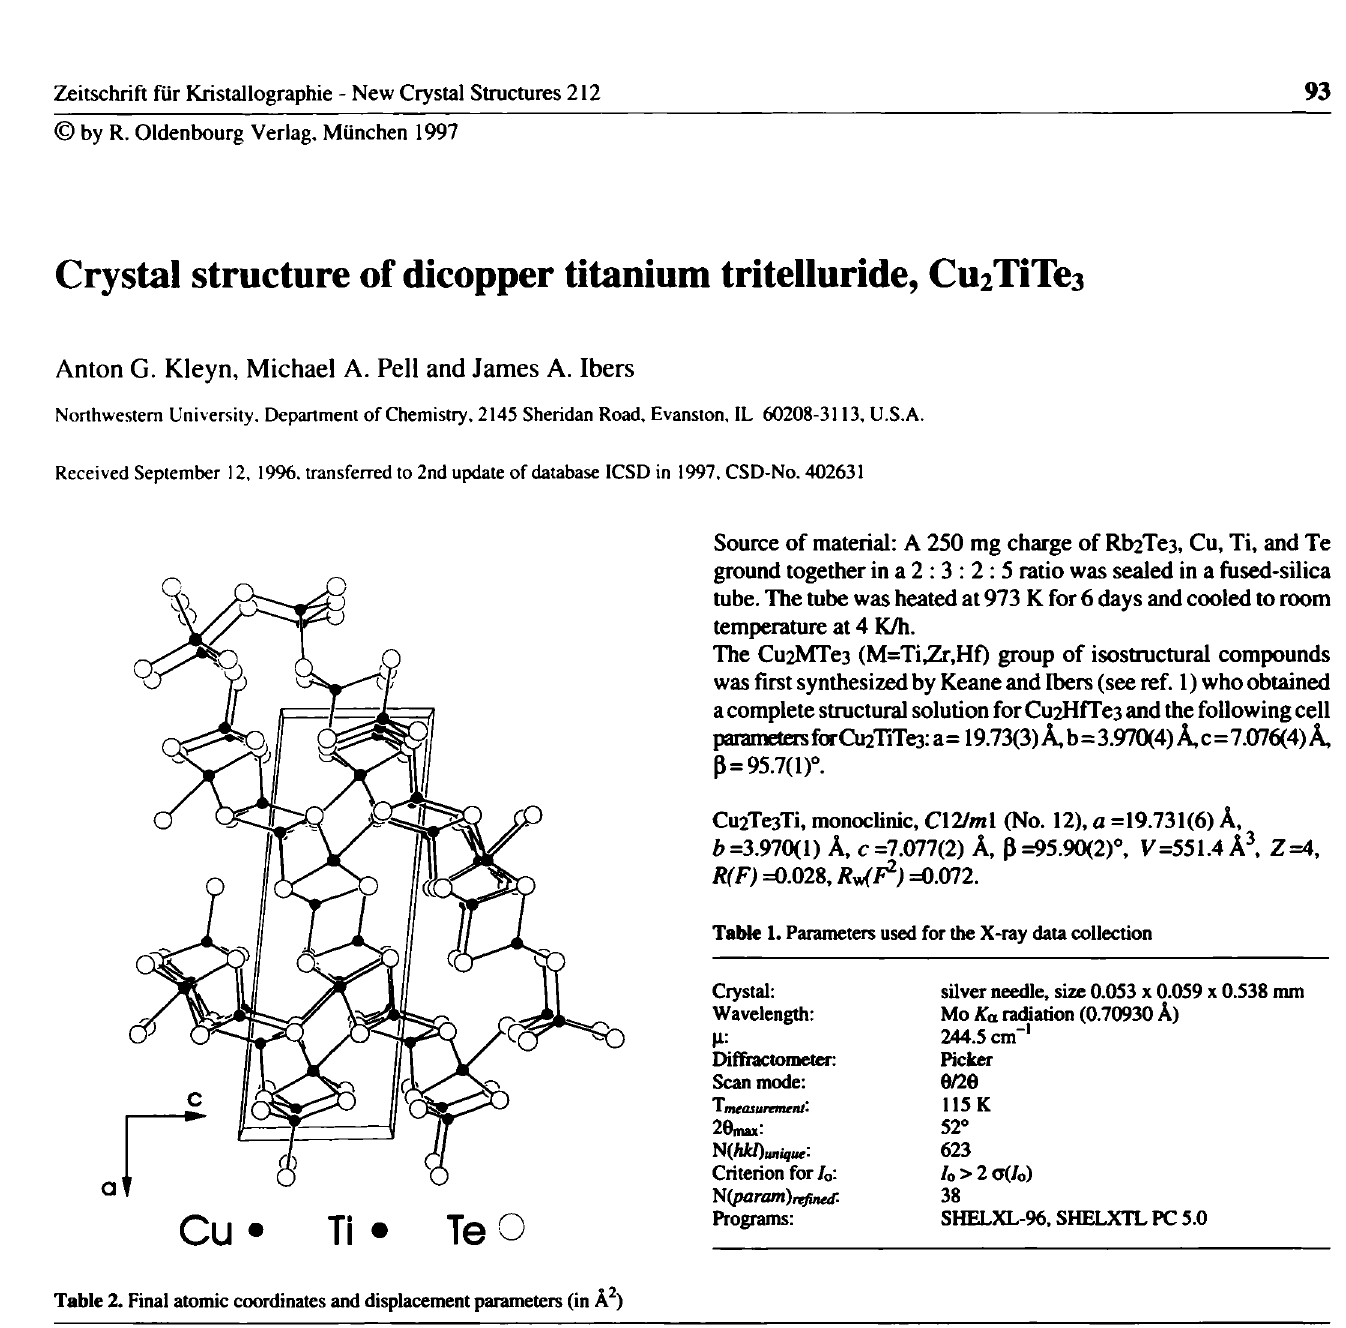
Table 2. Final atomic coordinates and displacement parameters (in Â 2 )